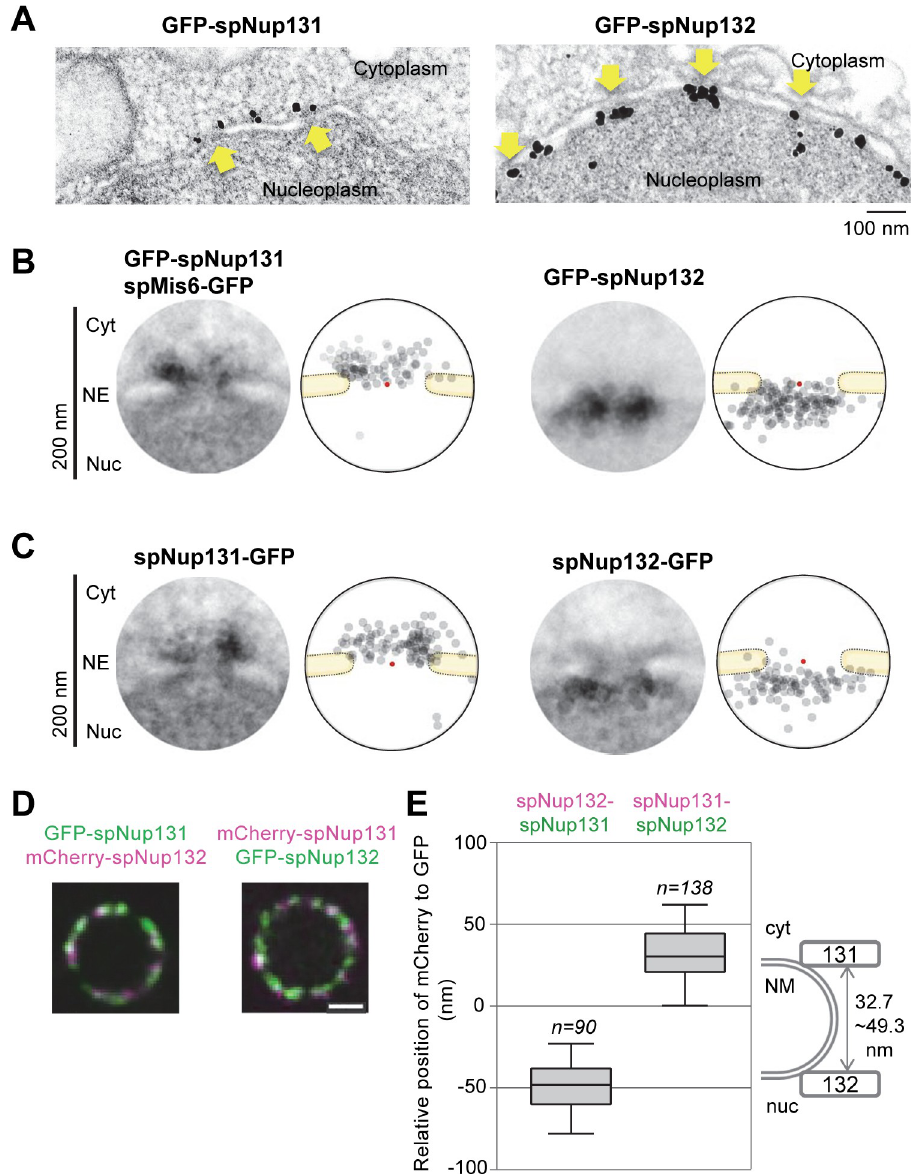
Fig 1. Localization of spNup131 and spNup132 at the NPC. (A) IEM of GFP-spNup131 and GFP-spNup132. Arrows indicate the nuclear pores. Scale bar, 100 nm. (B) Quantitative representation of IEM for N-terminally tagged spNup131 and spNup132. (left) A montage image of 20 immunoelectron micrographs. The diameter of the circle is 200 nm. (right) A schematic drawing illustrating the distribution of immunogold particles shown in the montage image. Red dots represent the pore centers. (C) Quantitative representation of IEM for C-terminally tagged spNup131 and spNup132. Montage pictures and distributions of immunogold particles are shown as described in (B). IEM micrographs used for the quantitative analysis are available in S1 Dataset. (D) Fluorescence microscopy of a nucleus simultaneously expressing spNup131 and spNup132 fused to GFP and mCherry in living cells. Single section images of the same focal plane are shown. (left) A nucleus expressing GFP-spNup131 and mCherry-spNup132. Green, GFP- spNup131; Magenta, mCherry-spNup132. (right) A nucleus expressing mCherry-spNup131 and GFP-spNup132. Magenta, mCherry-spNup132; Green, GFP-spNup131. Scale bar, 1 μ m. (E) Distances between spNup131 and spNup132 in living cells. Results from cells expressing GFP-spNup131 and mCherry-spNup132 (n = 90, left) and results from cells expressing mCherry-spNup131 and GFP-spNup132 (n = 138, right) are shown in the box plot: values of the distance determined in individual cells are shown in S2 Dataset. Center lines show the medians; box limits indicate the 25th and 75th percentiles. Whiskers extend to the 5th and 95th percentiles. The diagram on the right shows the positions of spNup131 and spNup132 within the NPC.